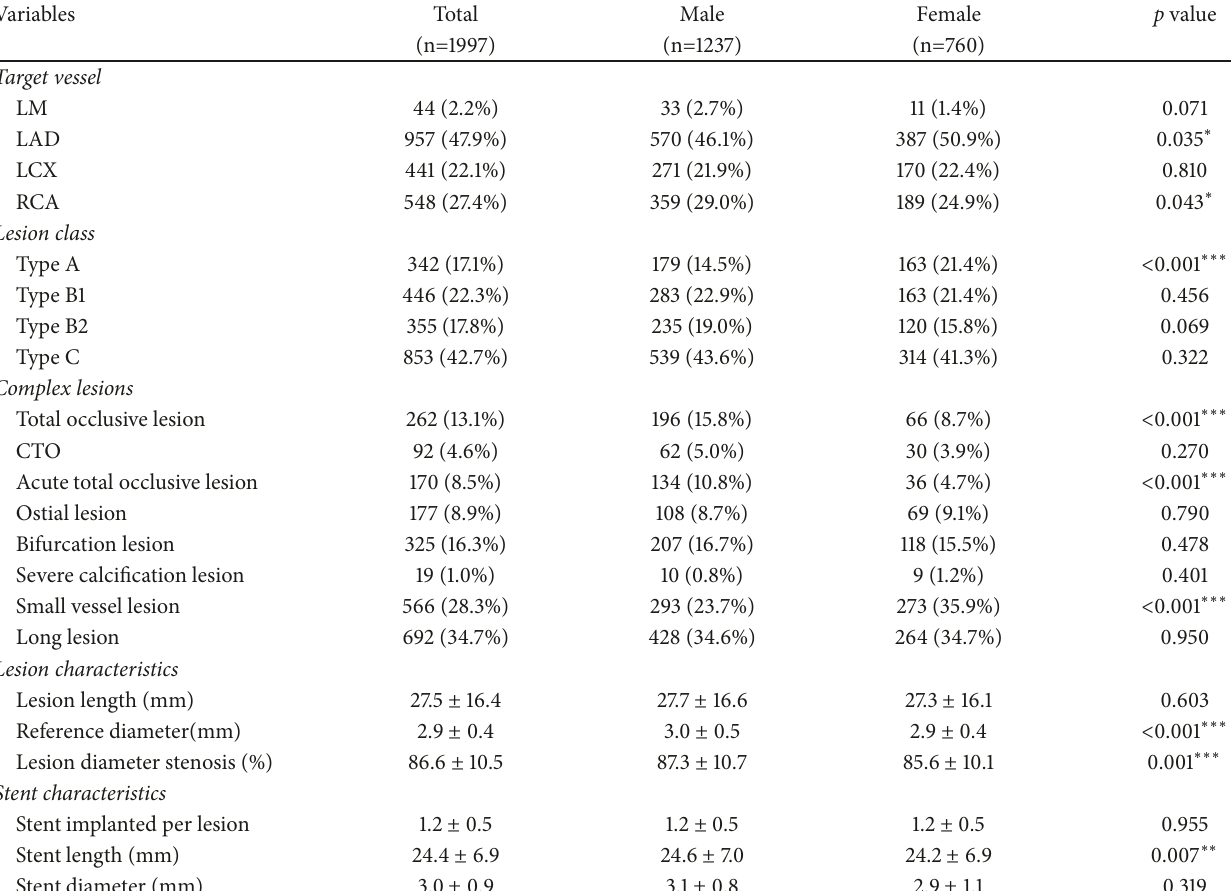
Table 2: Lesion characteristics: male versus female.